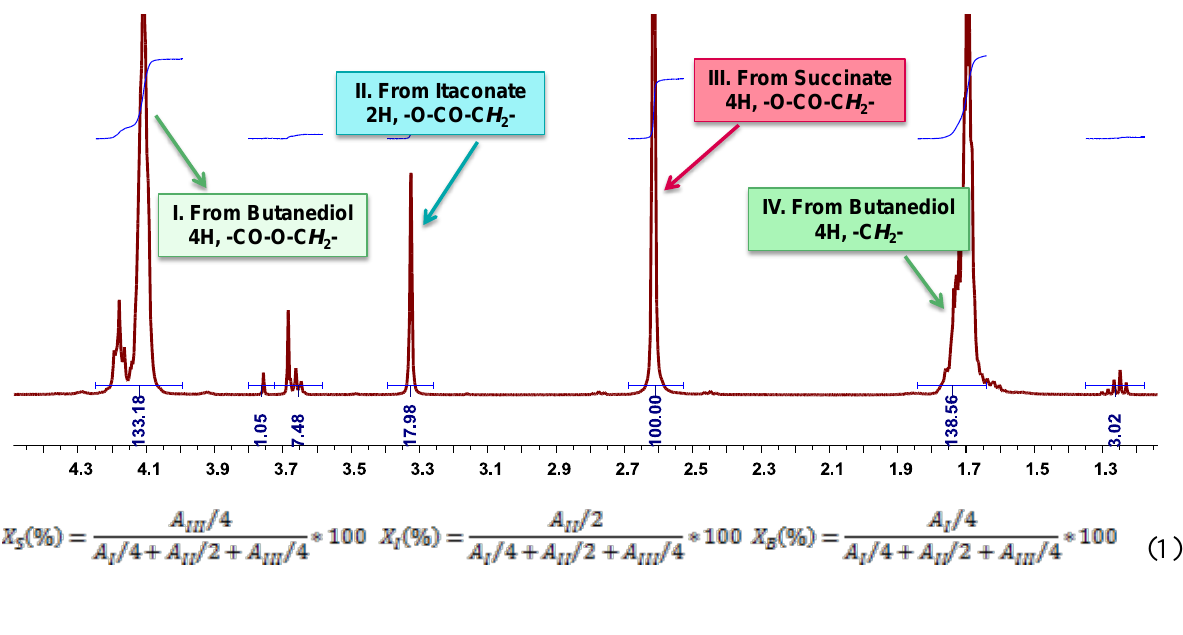
Figure 10. Calculation of the molar composition of PBSI from 1 H-NMR